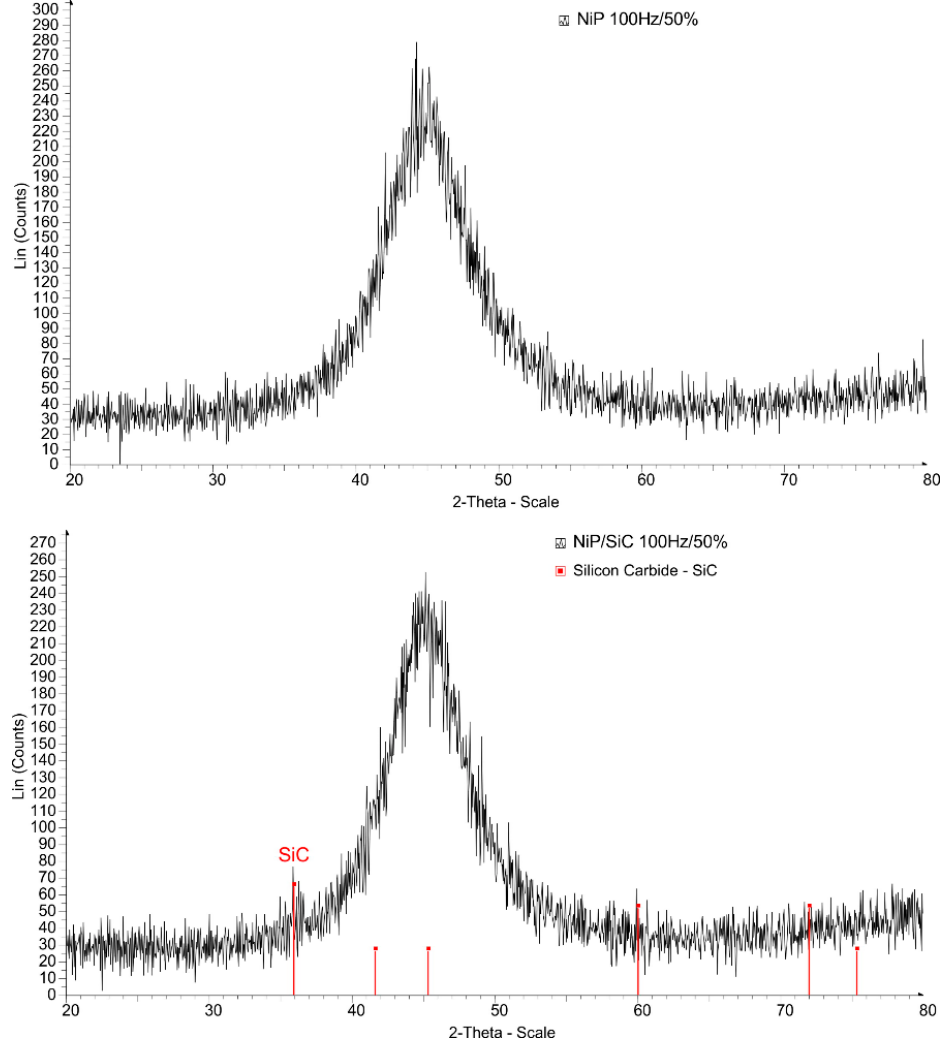
Figure 3. X-ray diffraction (XRD) spectra of the plain and SiC reinforced coatings developed at 50% duty cycle at 100 Hz prior to heat treatment.